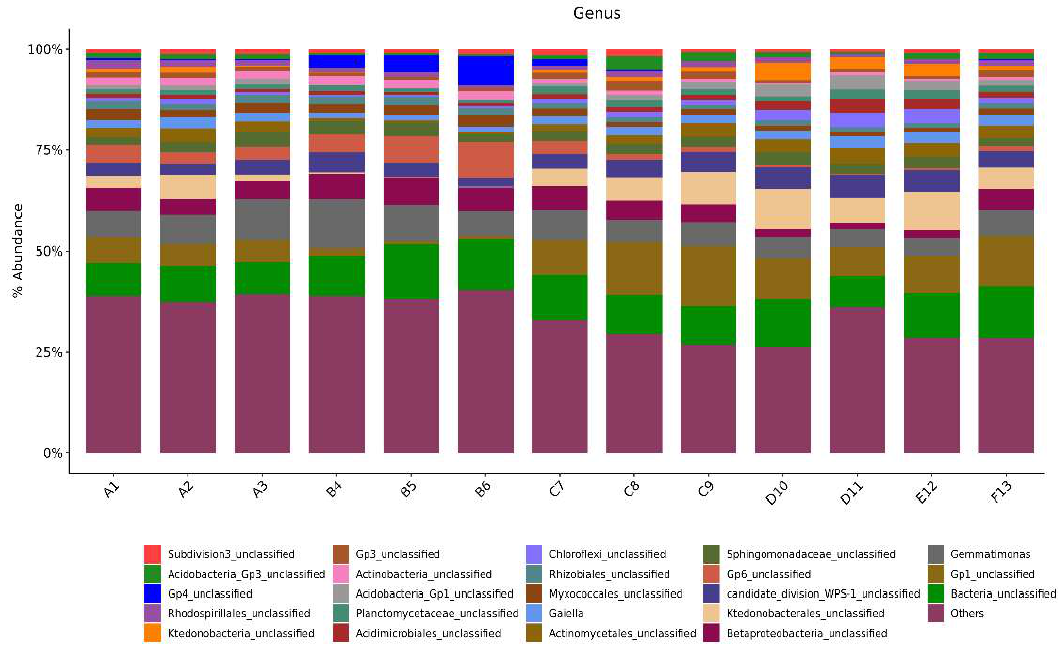
Figure 2. Change in microbial compositionat agenus level. A1–3: Commercial organic fertilizer at 0.75, 1.50, and 2.25 kg/m 2 ; B4–6: mushroom residue at 1.50, 2.25, and 3.00 kg/m 2 ; C7-9: biogas liquid at 150, 225, and 300 kg/m 2 ; D10–11: vegetable cake at 0.30 and 0.60 kg/m 2 ; E12: chemical compound fertilizer (37.50 g/m 2 ); F13: control.